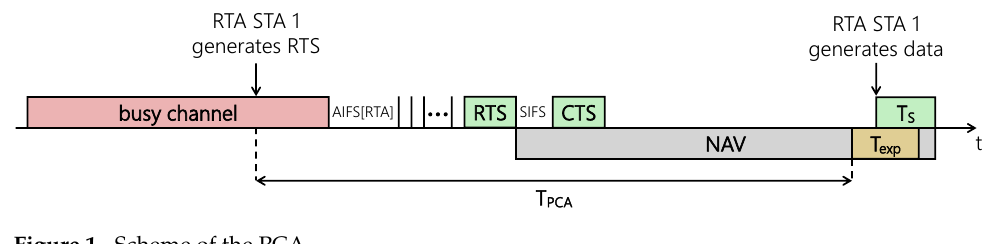
Figure 1. Scheme of the